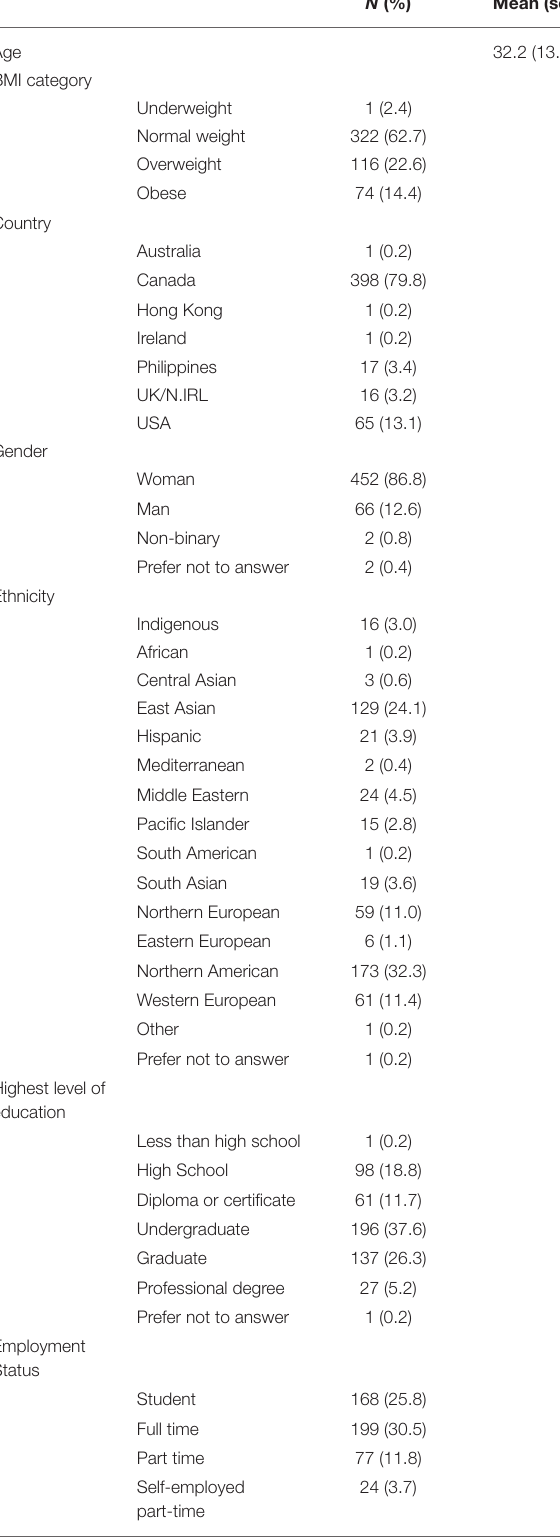
TABLE 1 | Demographic and descriptive characteristics of